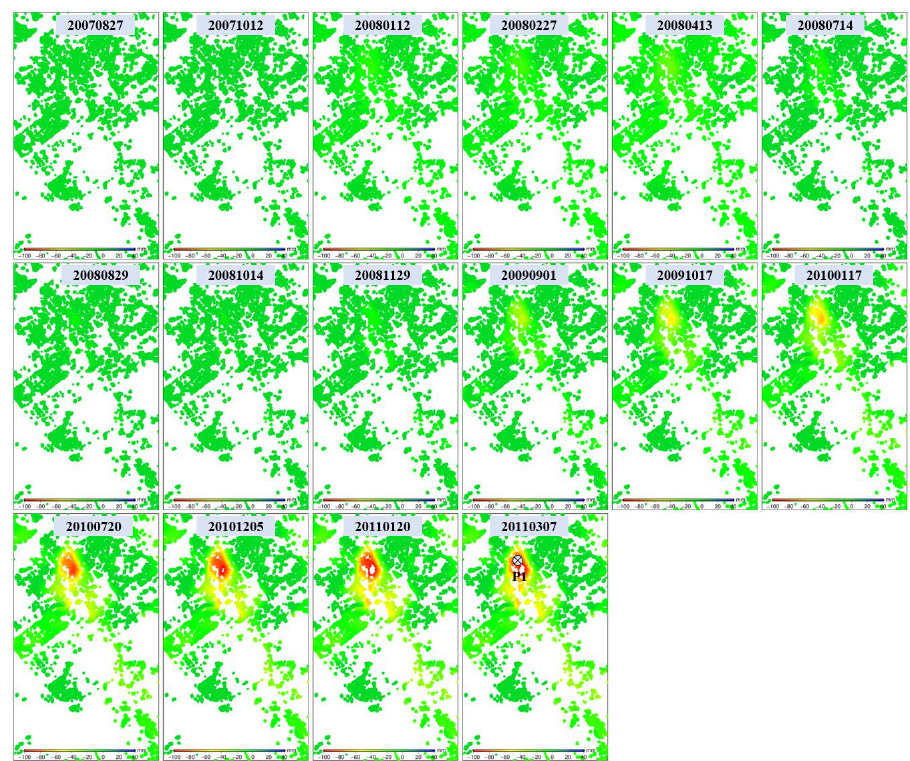
Figure 10. Time series deformation in Guandu (marked with black rectangles in Figure 5) observed from L-band ALOS-1 images. The time series deformation at point P1 will be extracted for further analysis. Sensors 2019 , 19 , x FOR PEER REVIEW